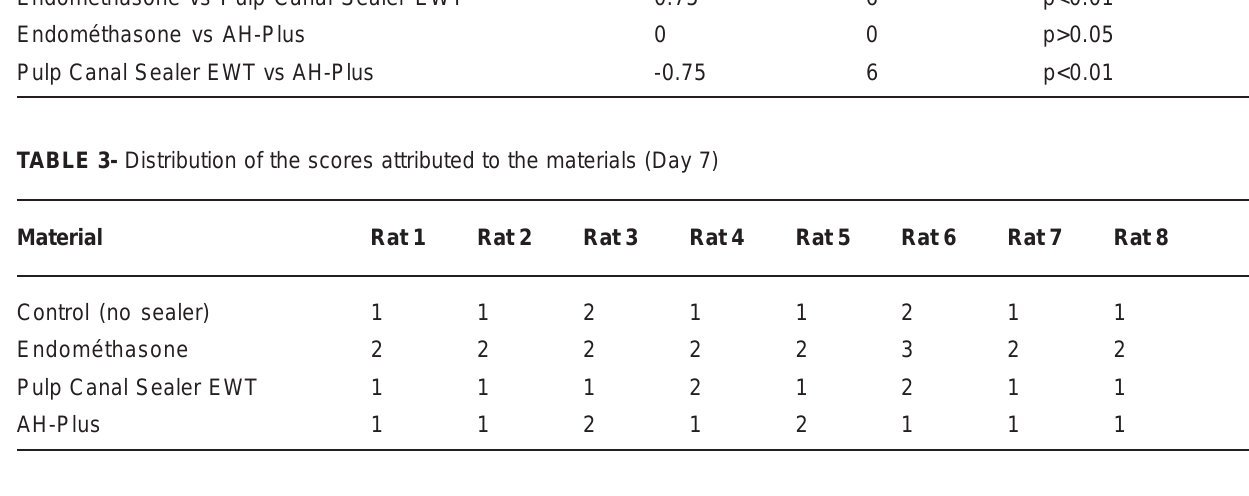
TABLE 4- Results of Tukey’s multiple comparison test for the scores attributed to the materials (Day